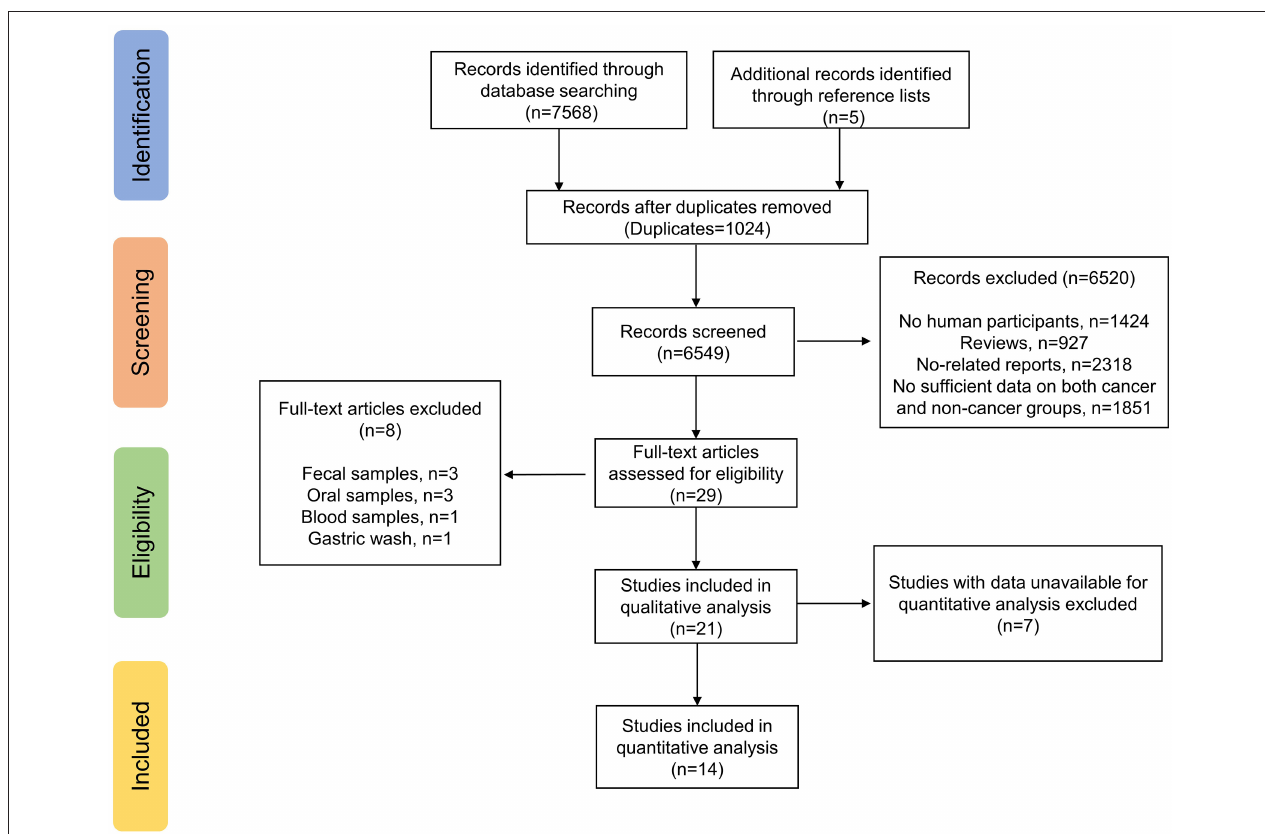
FIGURE 1 | Study flow